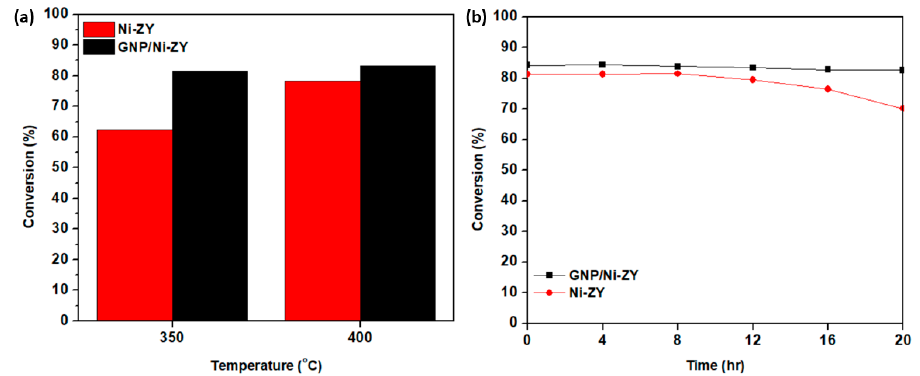
Figure 6. Conversion levels over Ni-ZY and GNP/Ni-ZY ( a ) at 350 and 400 °C reaction temperatures, ( b ) with stability results for 20 h of time-on-stream at 400 °C.